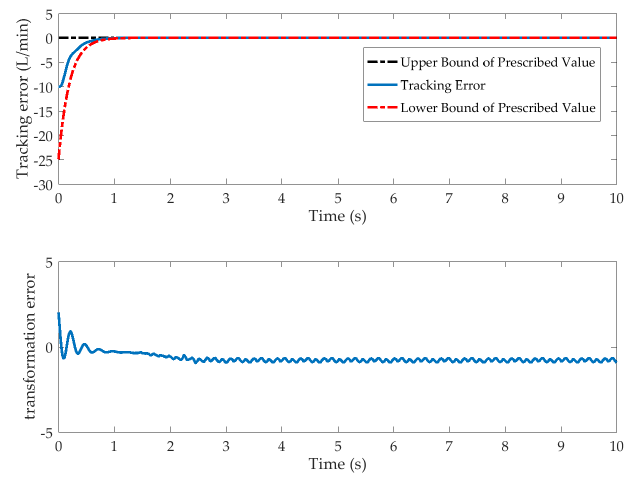
Figure 11. Time response of the performance function.